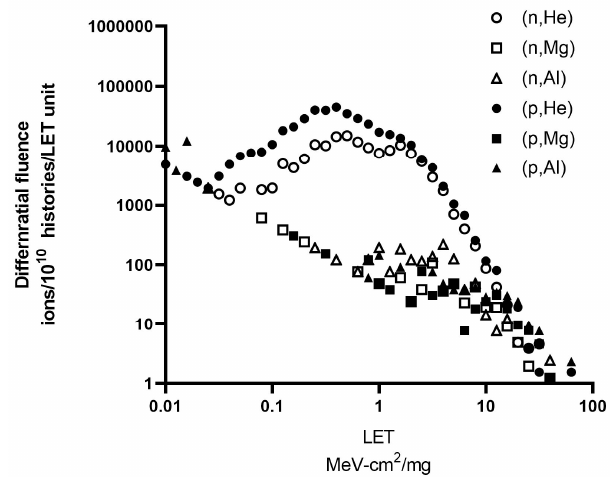
Figure 4. The LET contribution from He, Mg, and Al generated by the 200 MeV proton and the LANSCE neutron. In parentheses, the first symbol represents incident particles and the second symbol represents particles that contribute to the LET.